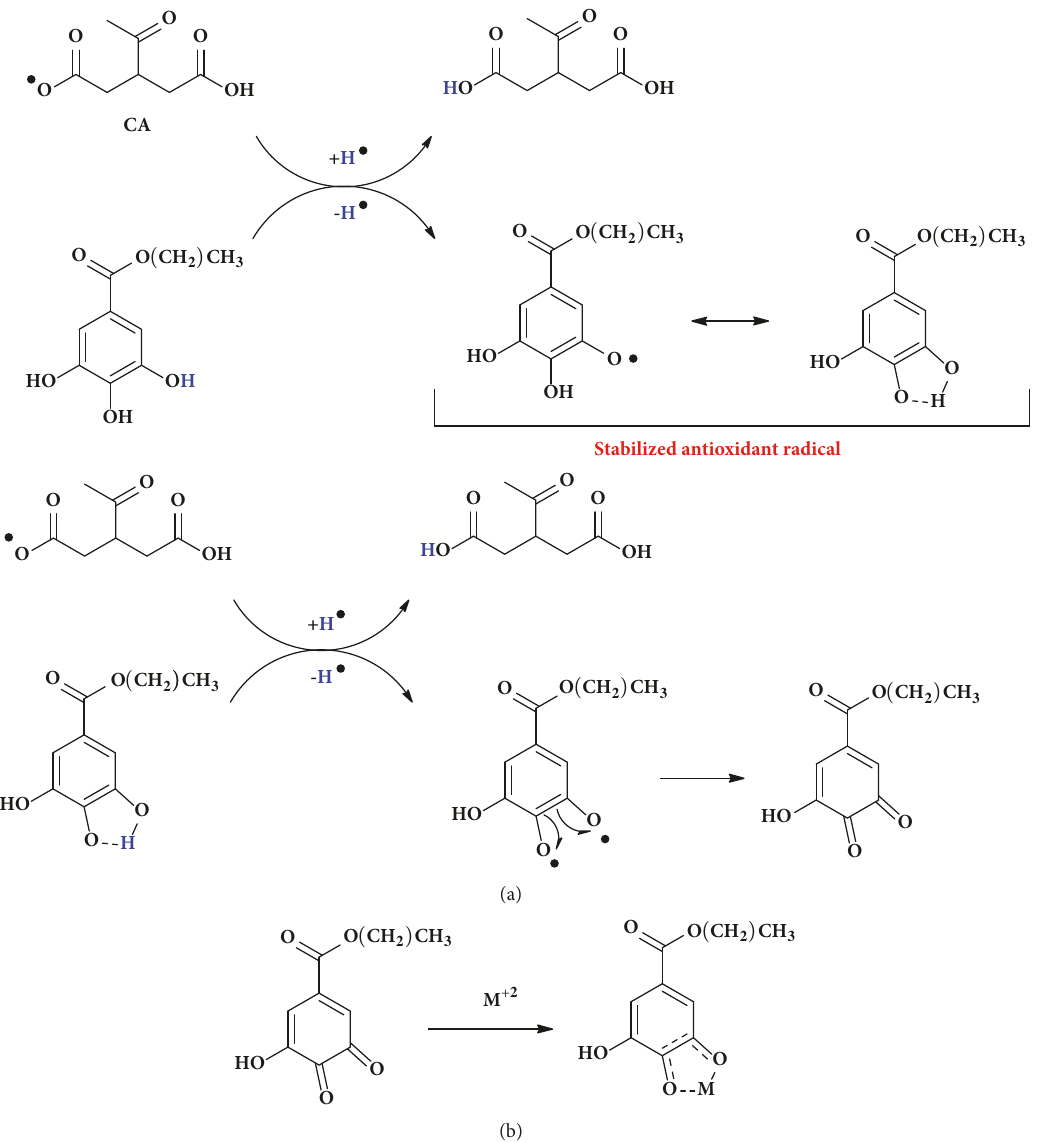
Figure 4: Proposed mechanism for the competitive synergistic interactions between p-CH 3 , CA, and PG. (a) Cycle of regeneration of CA and (b) chelation of diketone from PG with metals from metallic